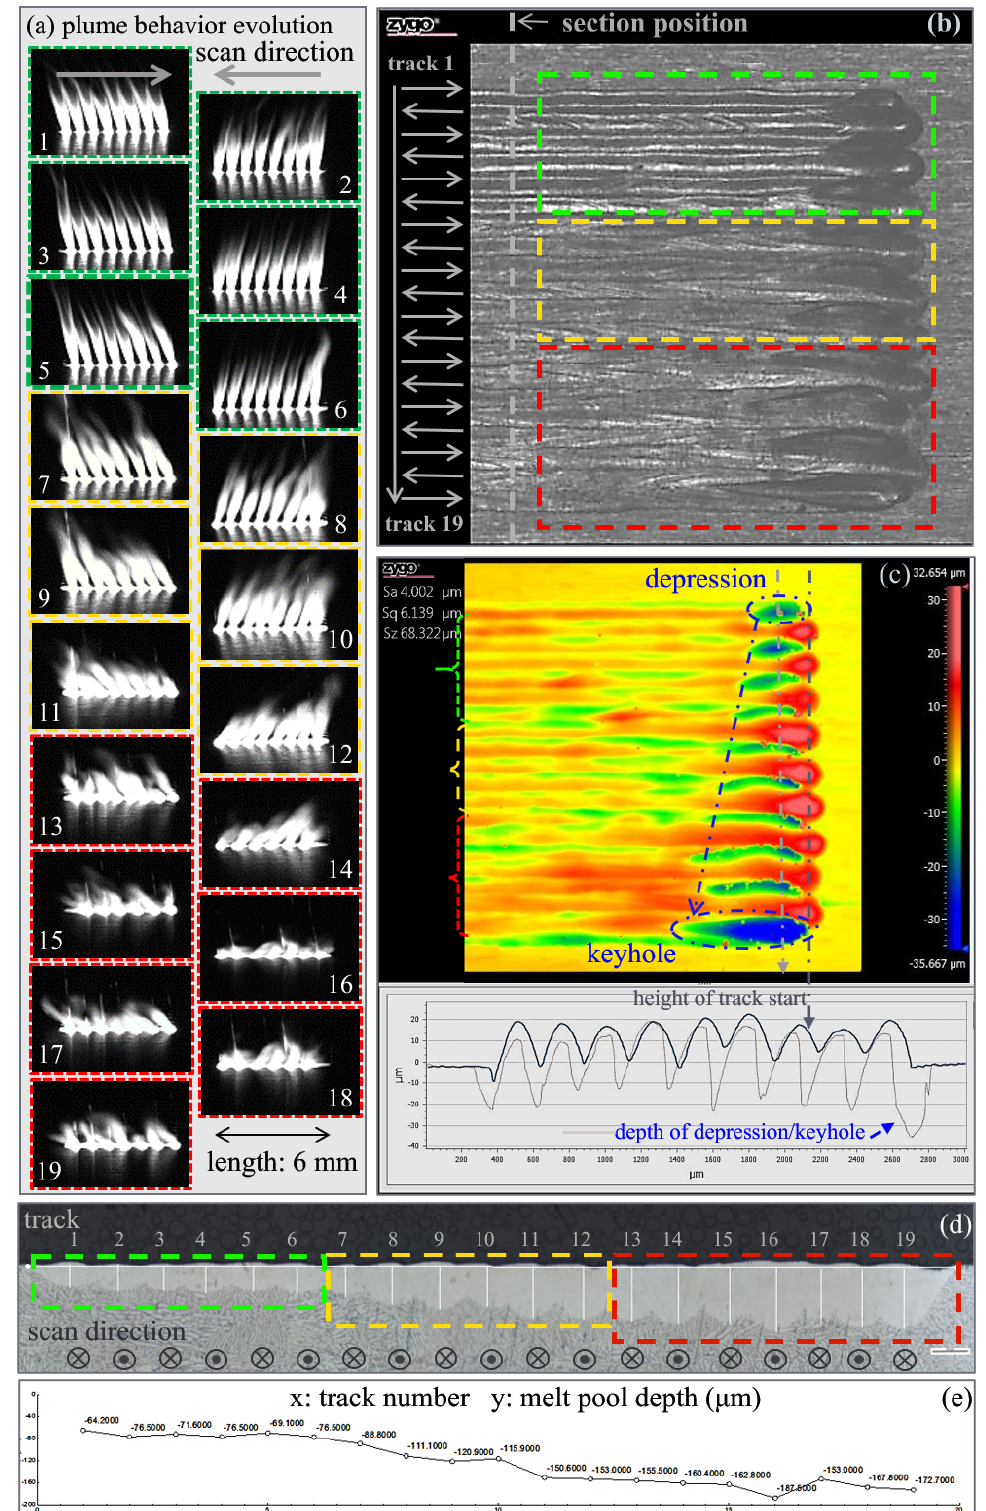
Figure 6. Correlation of plume behavior and melting quality in multi-track laser scanning at 300 W–600 mm/s. ( a ) Track-by- track superimposed images of plume evolution, the vertical plumes at the starting stages of each track are omitted for better clarity; the arrow indicates laser direction of the column and the track number are placed next to the track start. ( b ) Surface quality of the scanned layer. The gray arrows indicate scan direction and track succession, while the dashed line shows where the sample was sectioned. ( c ) 3D height map of surface roughness. ( d ) Cross section evolution. ( e ) Penetration depth measurement